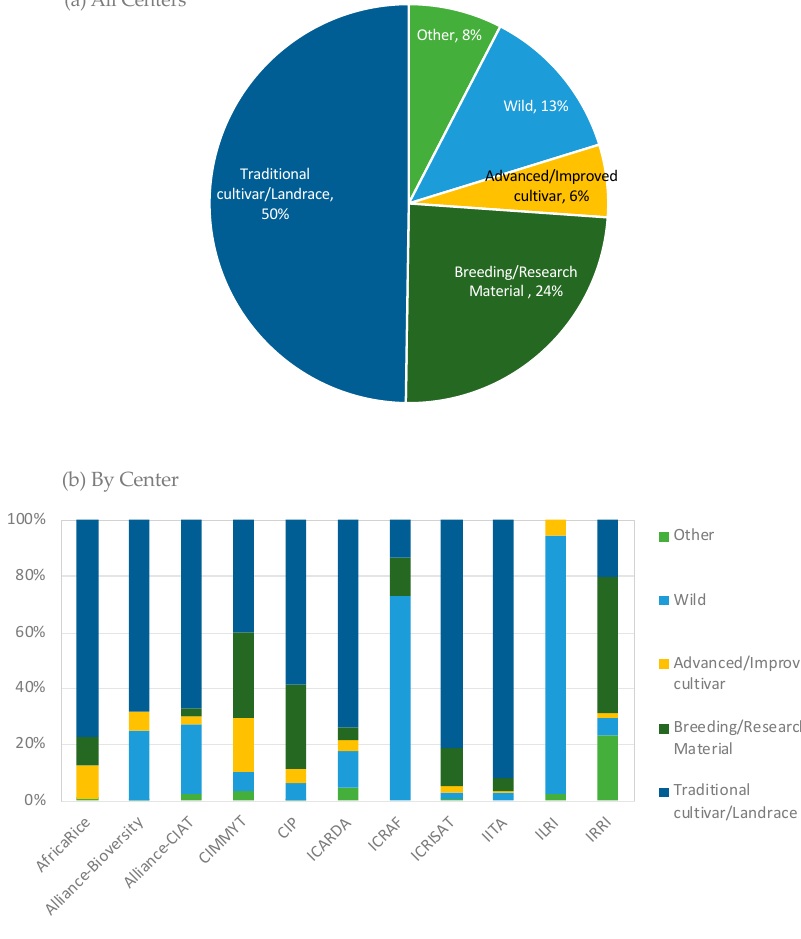
Figure 5. Types of germplasm distributed by CGIAR genebanks, 2017–2019 .